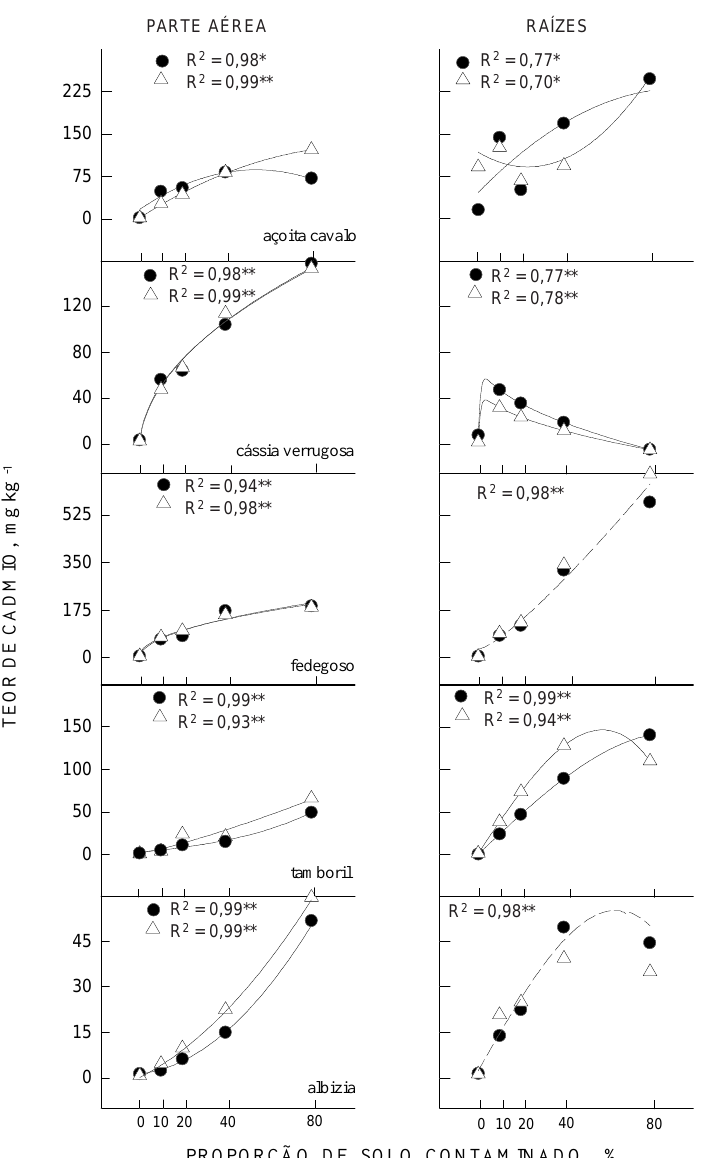
Figura 3. Teores de Cádmio no açoita-cavalo, cássia verrugosa, fedegoso, tamboril, albizia após o transplantio para mistura com diferentes proporções de solo contaminado: (cid:190) (cid:190)(cid:190) (cid:190)(cid:190) (cid:190)(cid:190) (cid:190)(cid:190) (cid:190) : plantas inoculadas; (cid:190)D(cid:190)(cid:190)D(cid:190)(cid:190)D(cid:190)(cid:190)D(cid:190)(cid:190)D(cid:190) ; plantas sem inoculação; -----: sem interação.